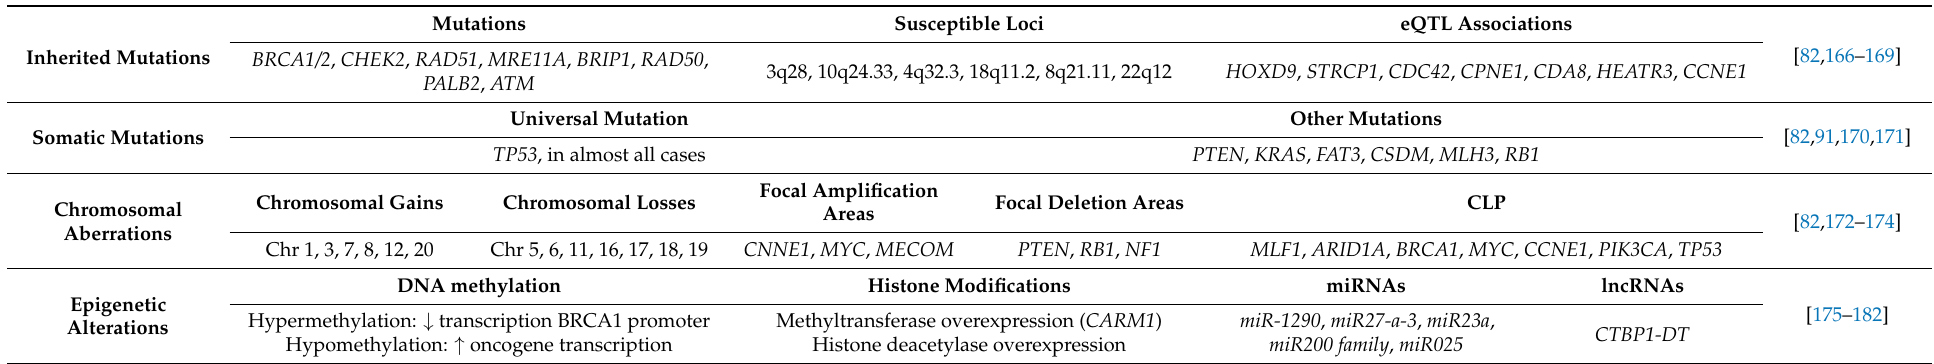
Table 1. Genetic and epigenetic traits involved in the etiopathogenesis of HGSOC. Major genetic alterations include inherited mutations, somatic mu- tations, chromosomal aberrations, and epigenetic alterations, which may be considered for the early diagnosis, prognosis, and follow-up evaluation of